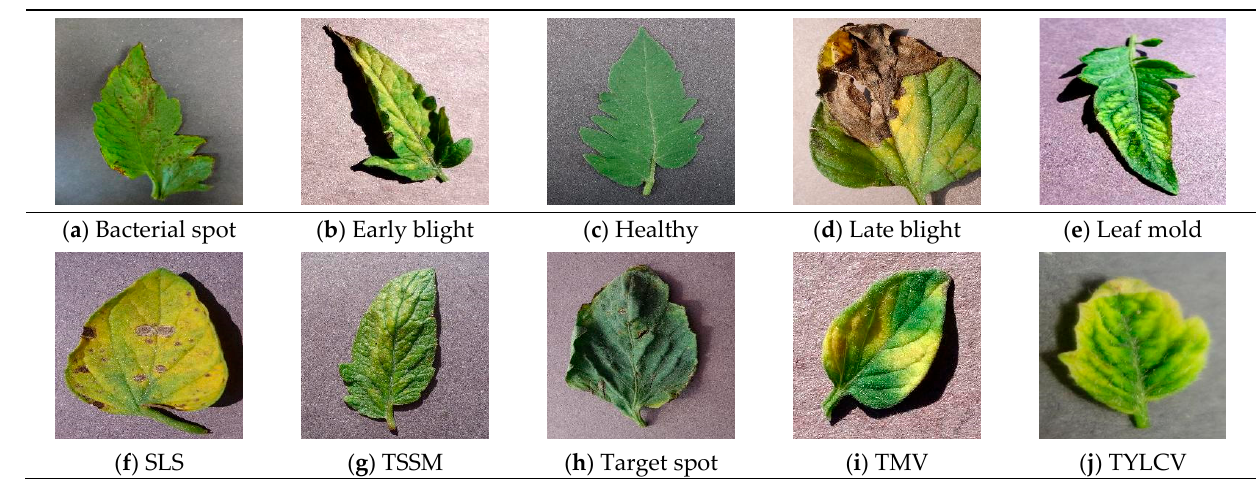
Figure 2. Examples of tomato images from PlantVillage dataset.